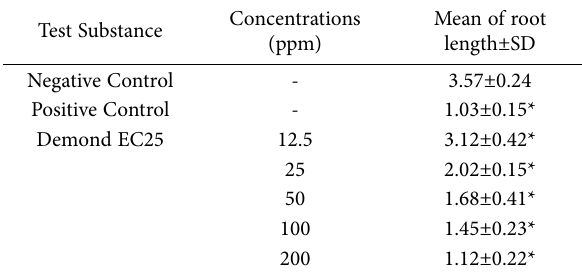
Table 1. Allium root growth inhibition test. Test Substance